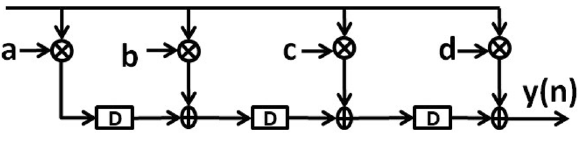
Fig. 4 DFG for low-pass 3rd-order broadcast FIR filter